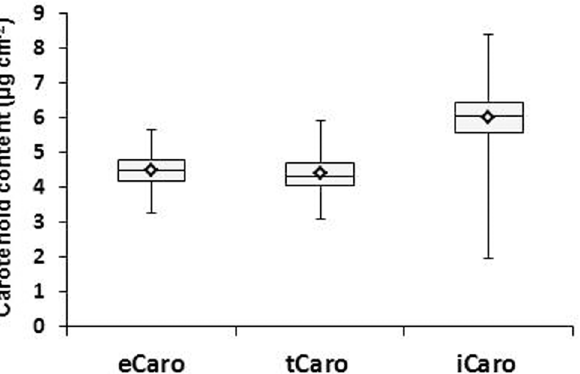
Fig 2. Box plot showing differences in carotenoids across two years (2009 and 2010) using extractable carotenoid content (eCaro), wavelet transformed spectral reflectance carotenoid content (tCaro) and spectral index carotenoid content (iCaro). Box edges represent the upper and lower quartile with median value shown as a bold line near the middle of each box. Mean values are represented by the diamonds and the upper and lower whiskers represent the extreme